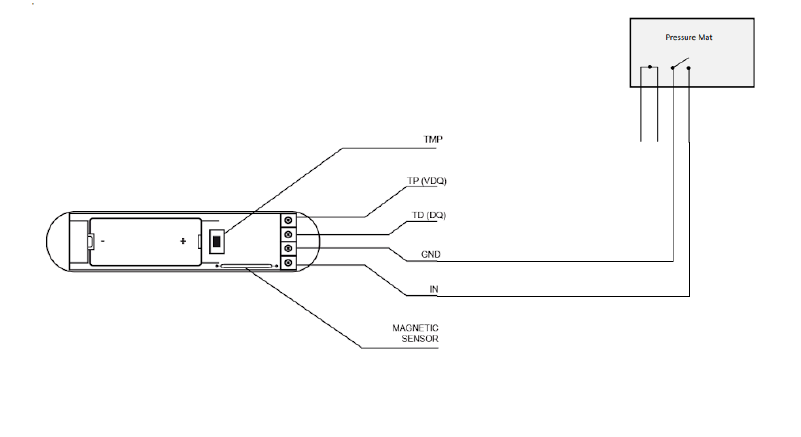
Figure 10. Bridge between Door/Window Sensor and Arun PM3.